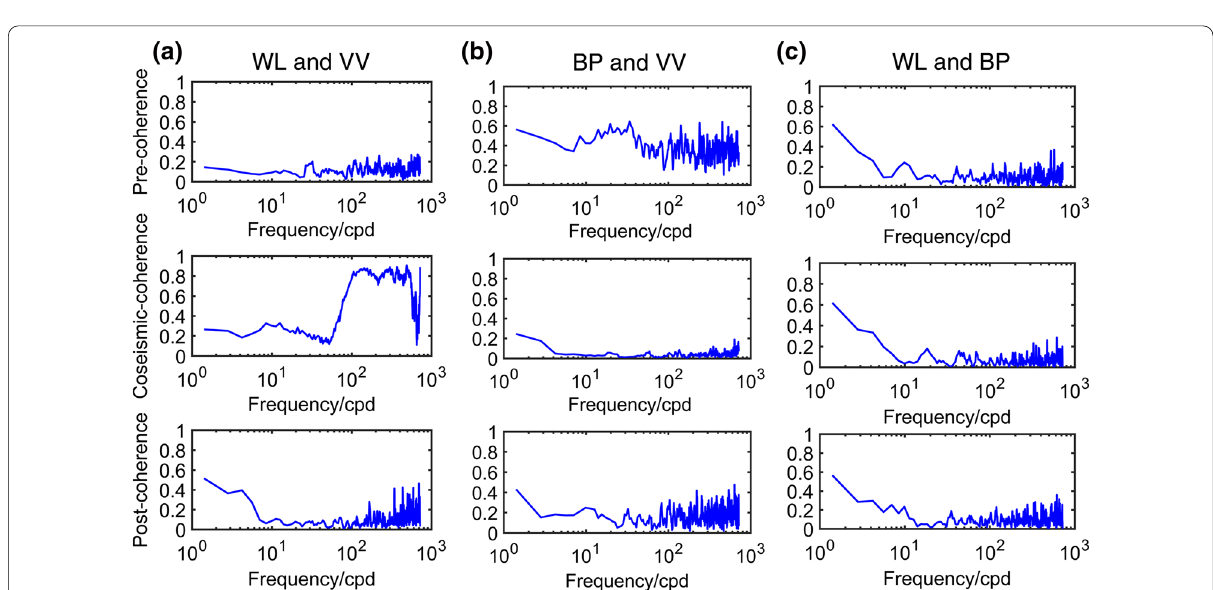
Fig. 6 Gorkha earthquake preseismic, coseismic and postseismic coherences between water level and vertical velocity ( a ), barometric pressure and vertical velocity ( b ), as well as water level and barometric pressure ( c ) in the LJ well. WL, VV and BP are abbreviations of water level, coseismic and barometric pressure,